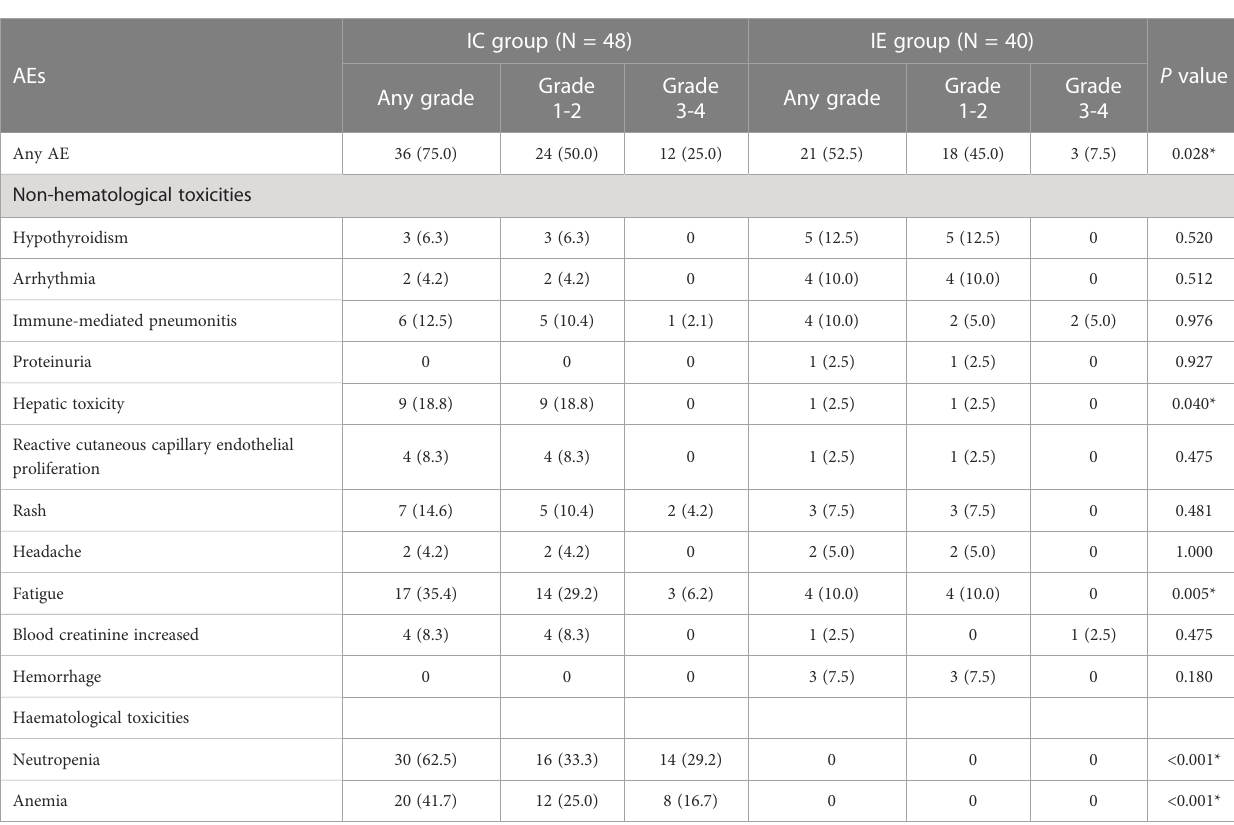
TABLE 4 Adverse events of two